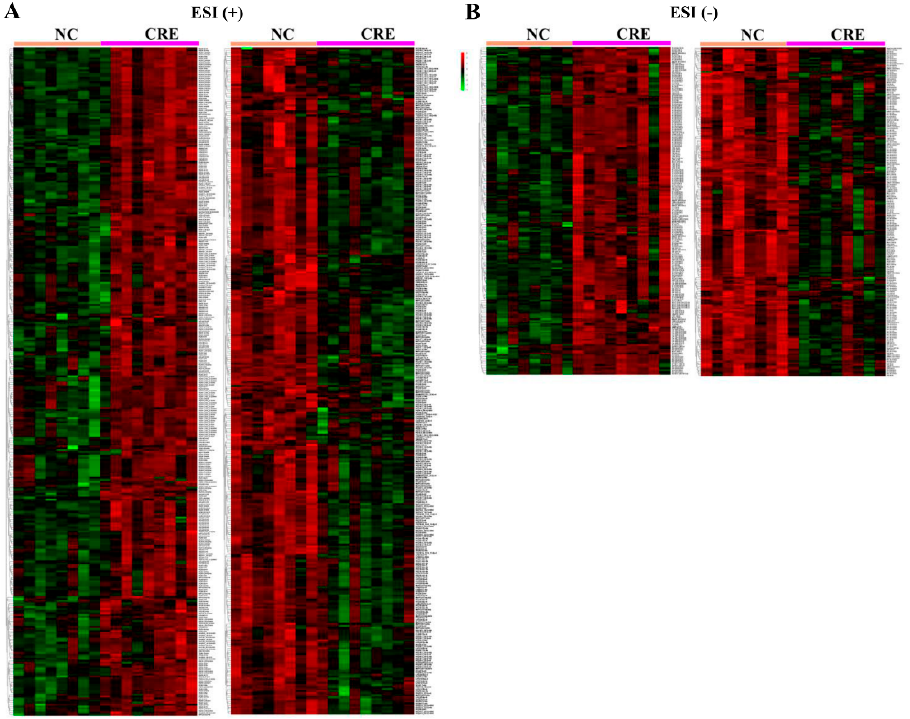
Figure 8. Heatmap showing the differential lipid species response to CRE exposure in the positive ion ( A ) and negative ion ( B ) modes.